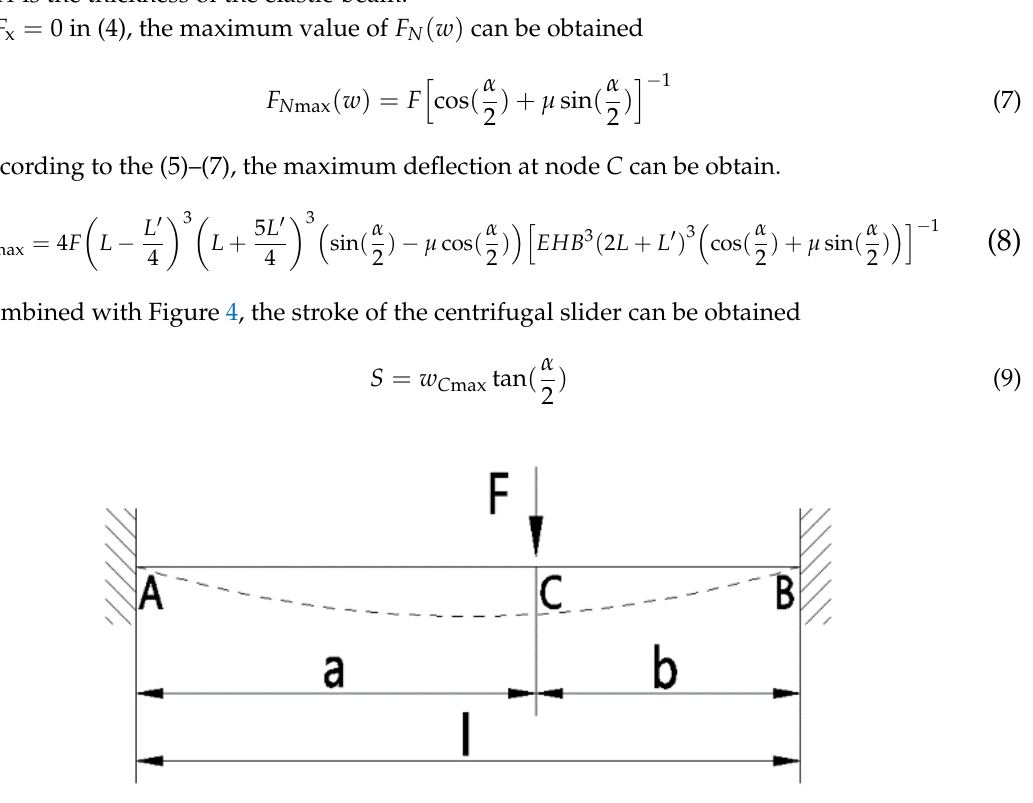
Figure 6. The schematic diagram of elastic-beam deflection analysis.